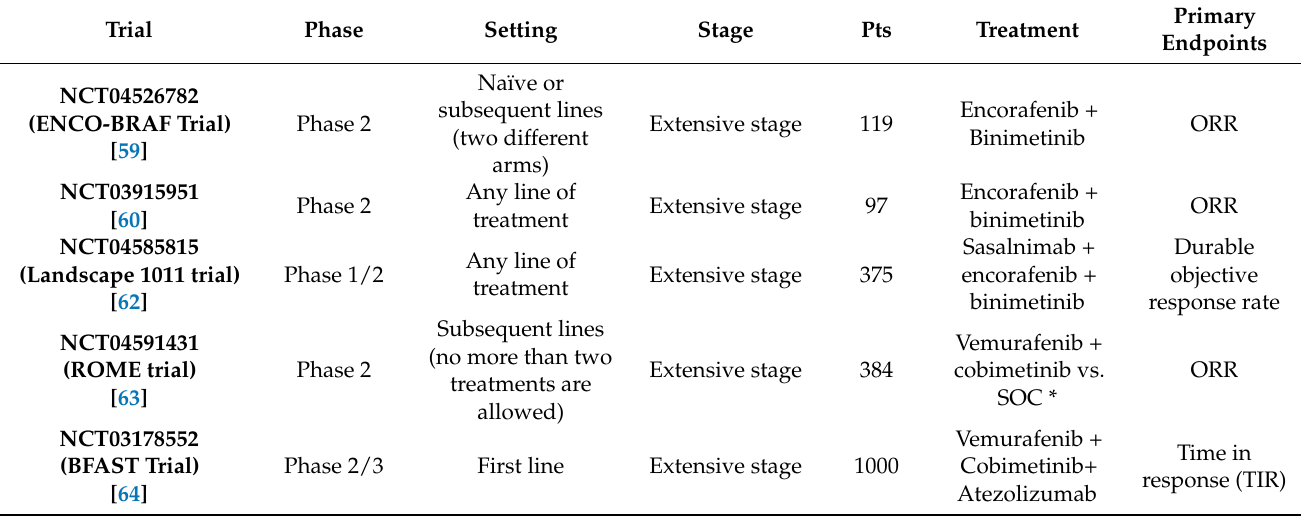
Table 2. Main ongoing studies with BRAF inhibitors in